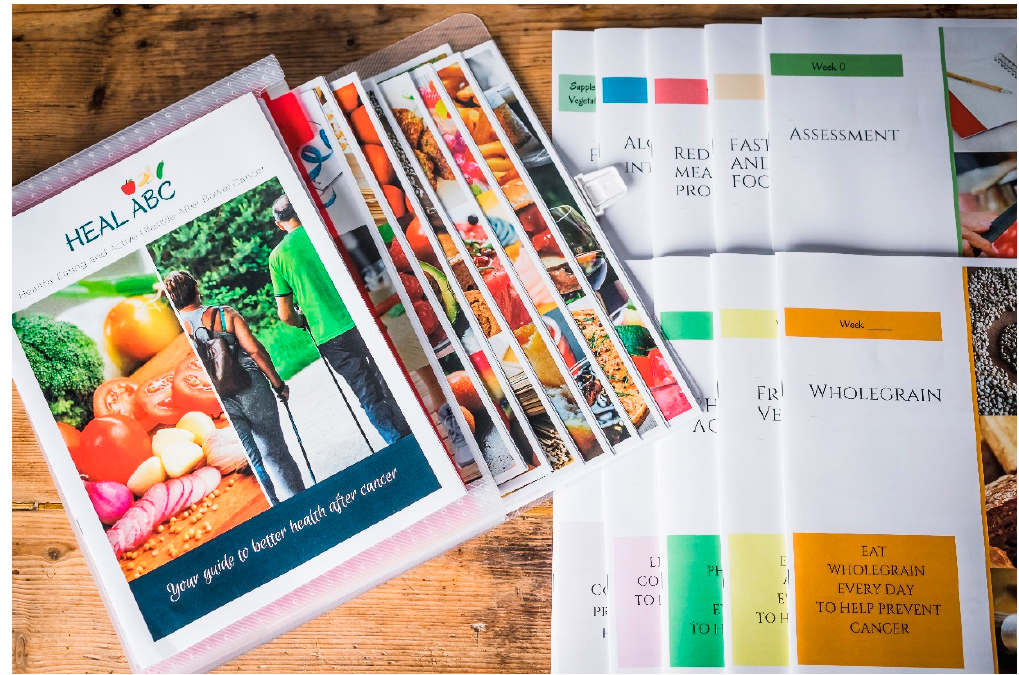
Figure 2. Healthy-Eating and Active Lifestyle After Bowel Cancer (HEAL ABC) resource.